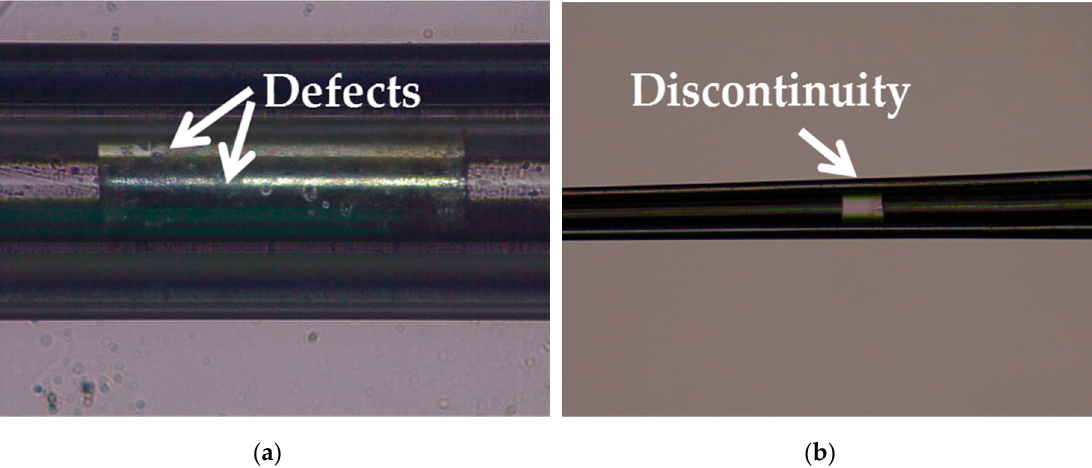
Figure 3. ( a ) Micrograph of the adhesion surface between the silver and the inner wall of the glass tube. ( b ) Micrograph of the discontinuity occurred in the internal silver wire.